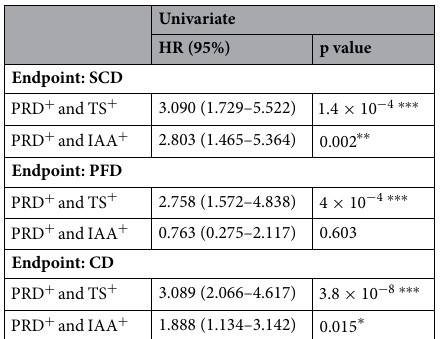
Table 6. Univariate Cox analysis results for PRD + and TS + , PRD + and IAA + , PRD + and TS + and PRD + and IAA + separately considering SCD, PFD or both as endpoints. ∗ p < 0.05 , ∗∗ p < 0.01 , ∗∗∗ p < 0.001 .